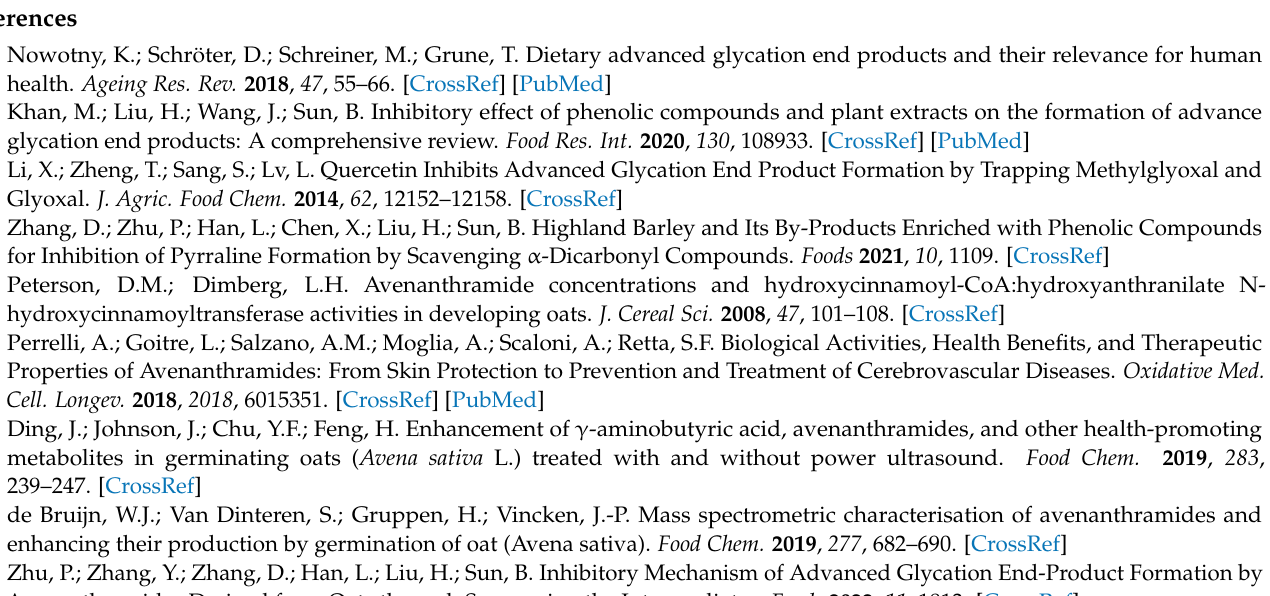
concentrations of AVAs 2f., Figure S2: The loading content of AVAs 2f for different FMIPs samples., Figure S3: (A) TEM image of CDs. (B) Size distribution of CDs., Figure S4: (A) SEM image of FMIPs without AVAs 2f. (B) TEM image of FMIPs without AVAs 2f (with the scale of 100 nm). (C) TEM image of FMIPs without AVAs 2f (with the scale of 500 nm; inset: size distribution of FMIPs without AVAs 2f). (D) EDS spectrum of FMIPs without AVAs 2f., Figure S5: (A) EDS images of FMIPs without AVAs 2f. (B) EDS images of C, (C) N, (D) O and (E) Si elements in FMIPs without AVAs 2f., Figure S6: (A) XPS spectrum of CDs. High-resolution XPS peaks of CDs: (B) C1s; (C) O1s; (D) N1s., Figure S7: Standard curves of different concentrations of PRL., Table S1: Dynamic model fitting of the cumulative release